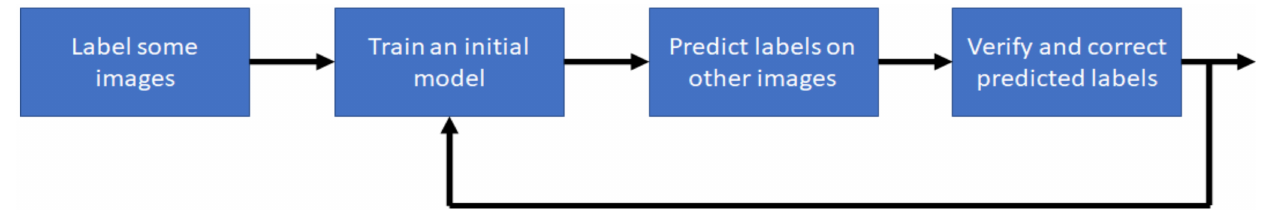
Figure 9. The workflow used to accelerate the labelling